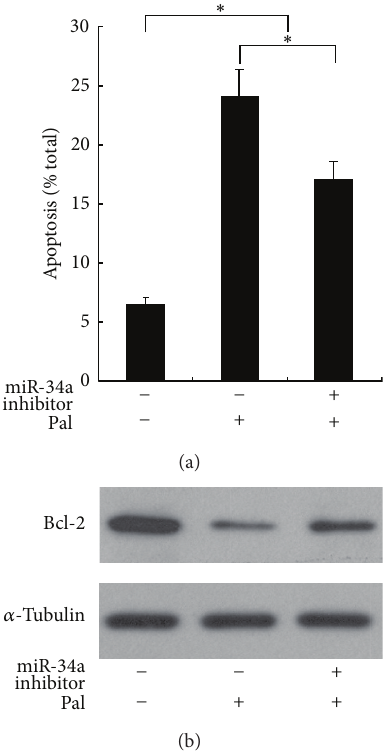
Figure 3: Pretreatment of miR-34a inhibitor antagonizes the effects of palmitate on pancreatic 𝛽 cell. Min6 cells were transduced with either miR-34a inhibitor or control oligonucleotides. Twenty-four hours later, indicated cells were treated with palmitate for 48h. The apoptotic rate of cells was determined by scoring the cells displaying pycnotic nucleus and/or fragmented nucleus (a) ∗ 𝑃 < 0.05 . The expression levels of Bcl-2 were assessed